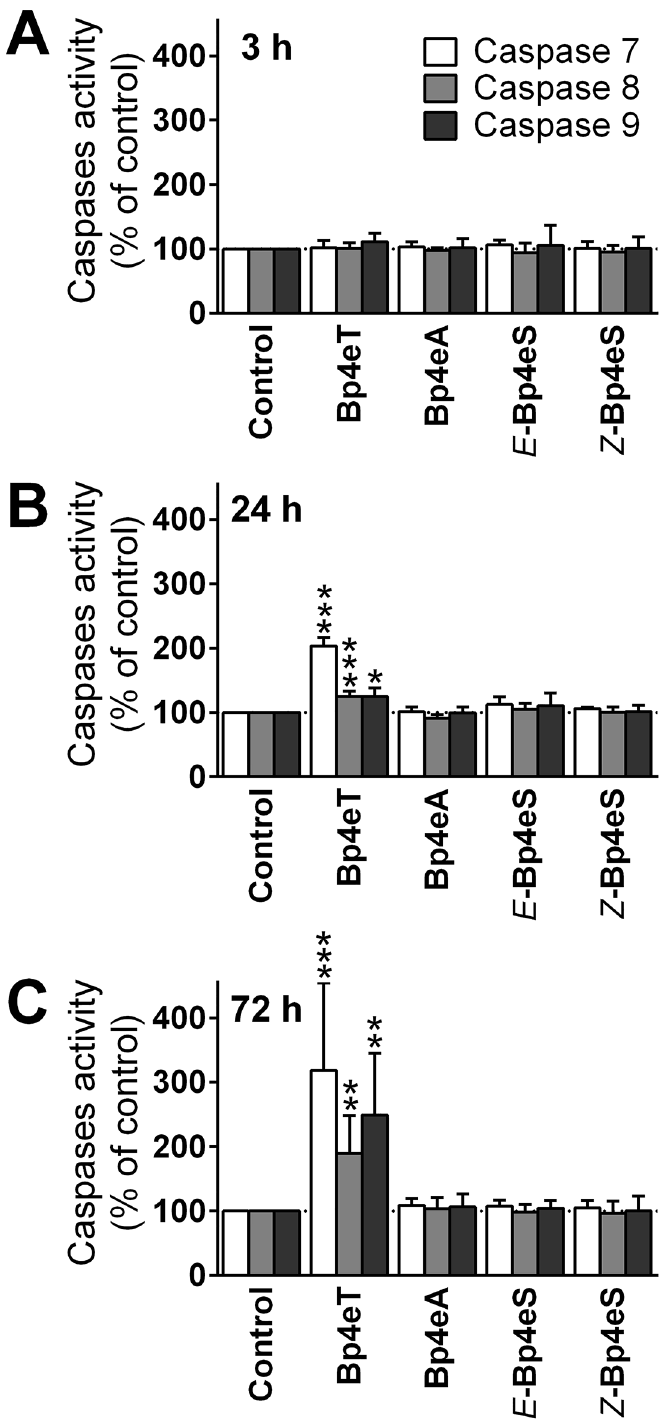
Fig 6. Incubation of Bp4eT with MCF-7 cells caused increased caspase activity, whereas its metabolites did not. MCF-7 cells were incubated for: (A) 3 h; (B) 24 h; or (C) 72 h/37°C with 100 nM Bp4eT or its metabolites, Bp4eA and Bp4eS. The caspase activities were then assayed in cellular lysates. The activities were related to cell viabilities and the results were expressed as a percentage of control. The results are mean ± SD ( n = 4 experiments). Statistical significance (ANOVA): * p < 0.05, ** p < 0.01, *** p < 0.001 as compared to the control (untreated)